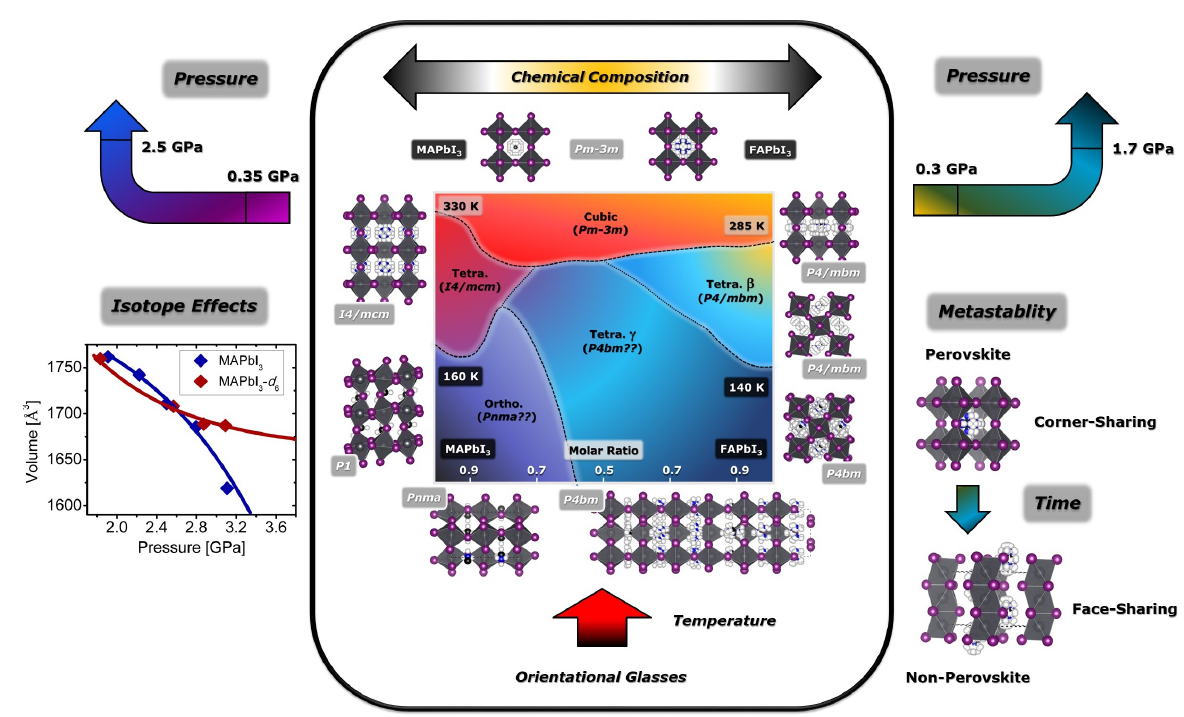
Figure 3. Phase diagram of MA 1 − x FA x PbI 3 solid solutions over the temperature range 10–365 K at ambient pressure. Pure MAPbI 3 (FAPbI 3 ) corrresponds to the left (right) edges of the diagram. For further details, see the main text. Adapted with permission from Refs. [75,81]. Copyright (2021) American Chemical